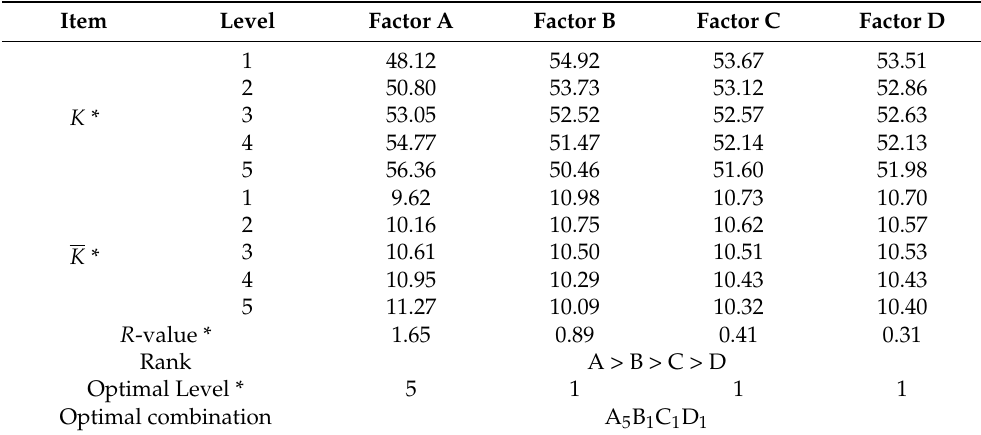
Table 6. Range analysis of indoor air